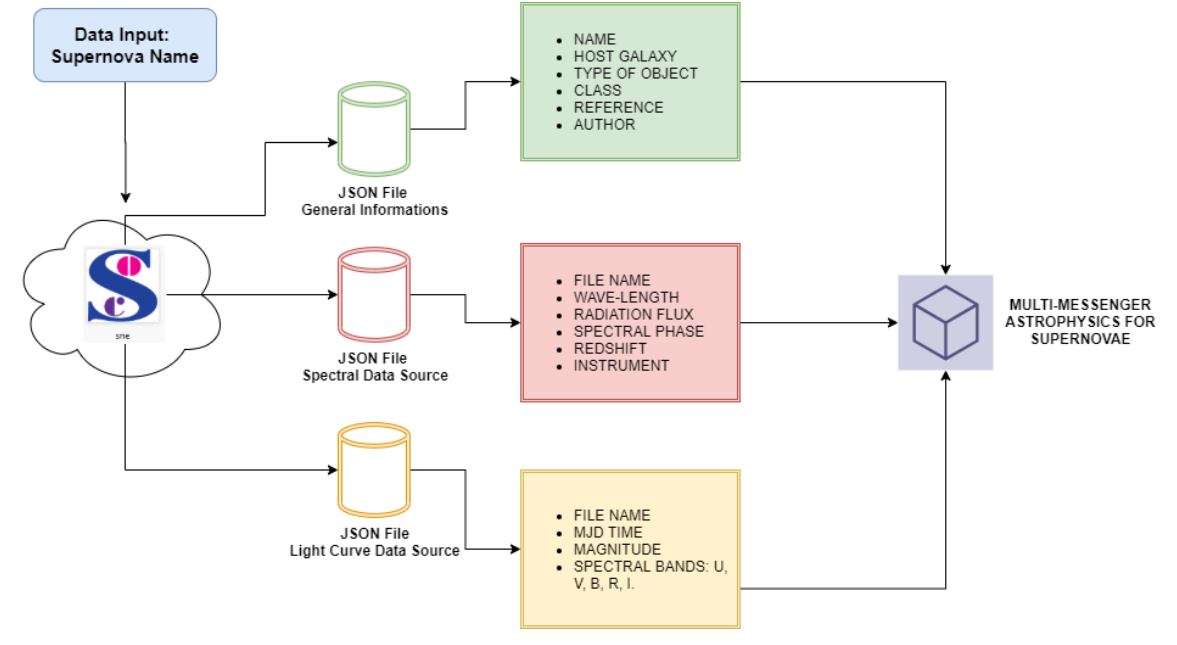
Figure 8. MMA-Supernovae Protocol.